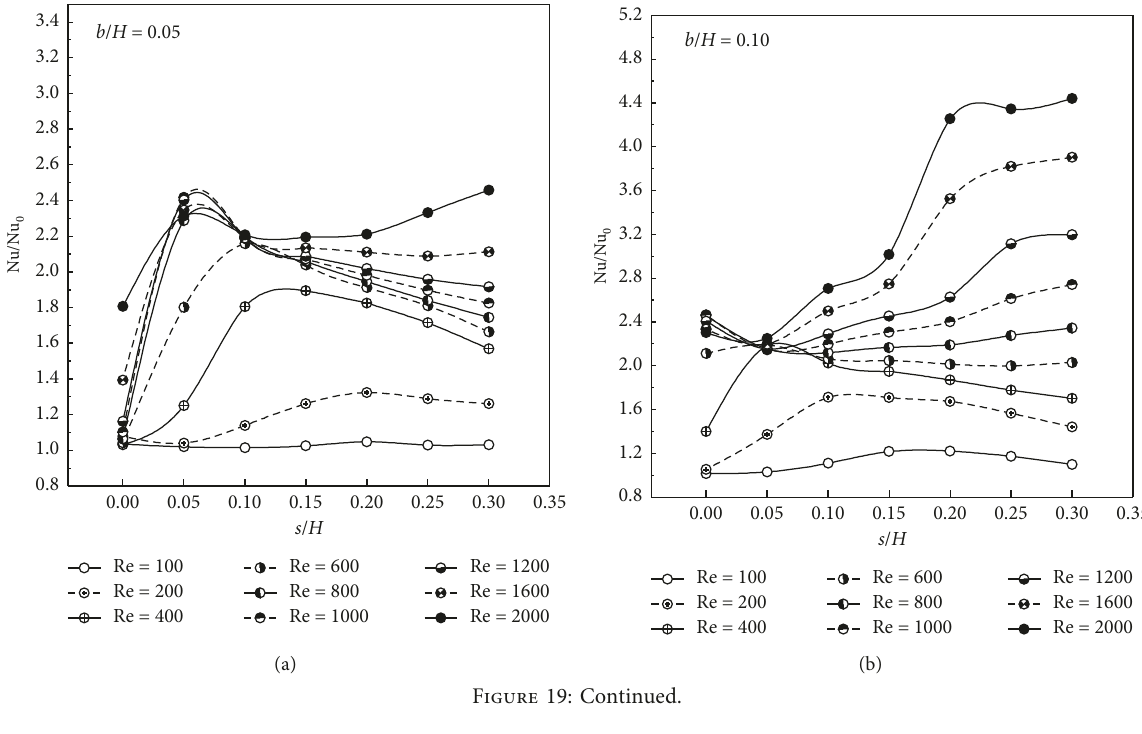
Figure 18: TEF versus Reynolds number for the heat exchanger square duct installed with the 45 ° ISR at (a) b / H H 0.15, (d) b / H 0.20, (e) b / H 0.25, and (f) b / H (cid:31) (cid:31) (cid:31)